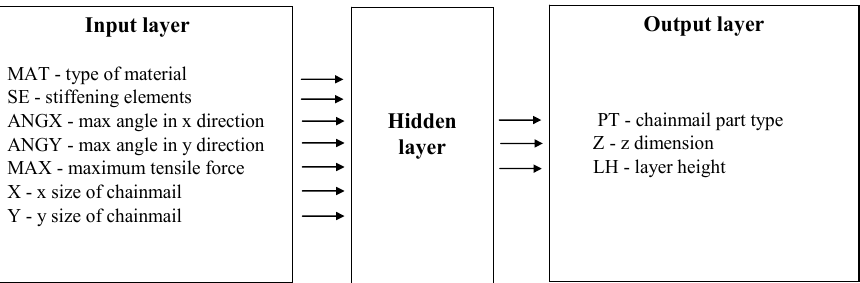
Figure 5. Traditional artificial neural network structure for chainmail’s parameters selection [29,30].